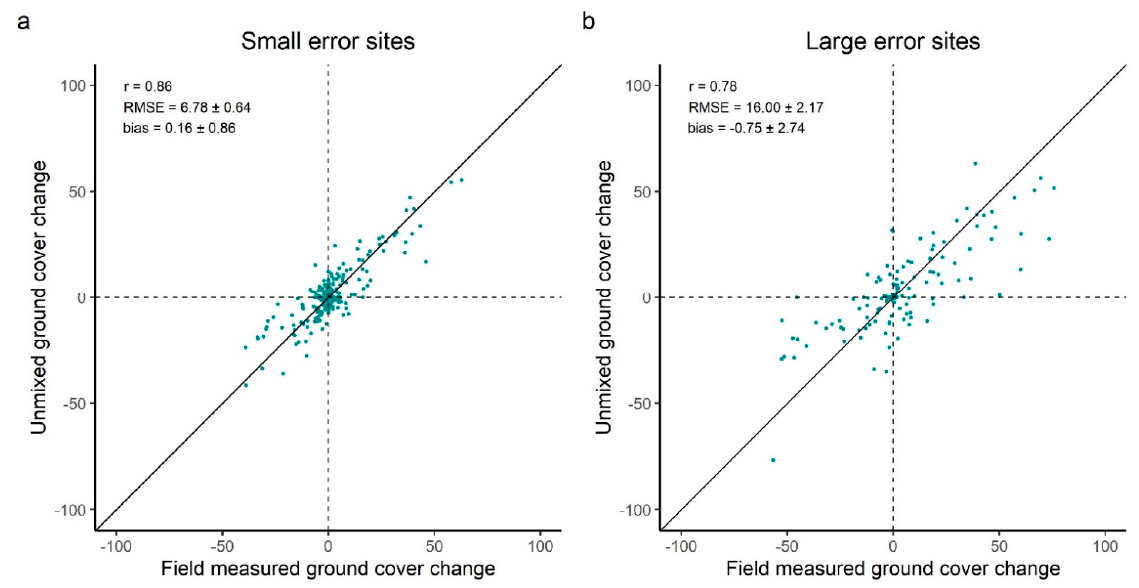
Figure 6. Scatterplots of field-measured and modelled total ground cover (100 –bare soil fraction (%)) change across the continent. The black line corresponds to the 1:1 agreement. Dashed lines on y = 0 and x = 0 are displayed to highlight the proportion of points falling on quadrants I (+, +) and III (-, -). ( a ) Scatterplots of sites where BS error < 15%, n = 261 (199 in drylands). ( b ) Scatterplots of sites where BS error > 15% at least once, n = 134 (104 in drylands).